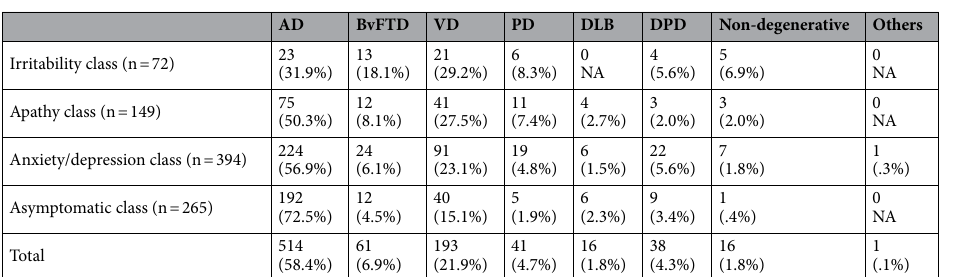
Table 5. Specific conversion type of dementia for 4 classes of preeminent neuropsychiatric symptoms. AD Alzheimer disease, BvFTD behavioral variant of fronto-temporal dementia, VD vascular dementia, PD Parkinson’s disease, DLB dementia with lewy bodies, DPD dementia by psychiatric disorder, Non-degenerative dementia by non-degenerative disorders, other dementia by others. Only converters are included here.